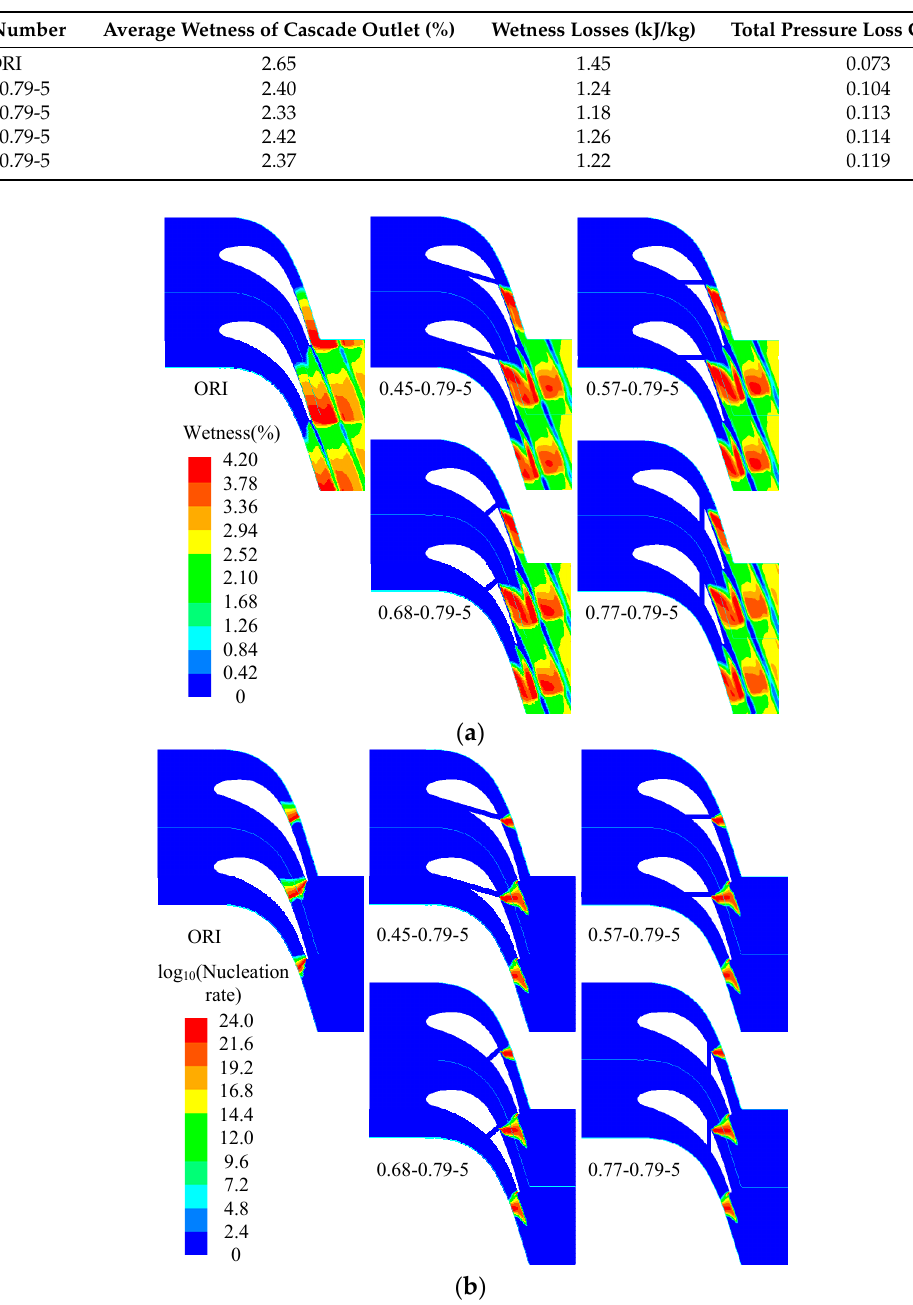
Figure 7. Distribution of ( a ) wetness and ( b ) nucleation rate (part 2).